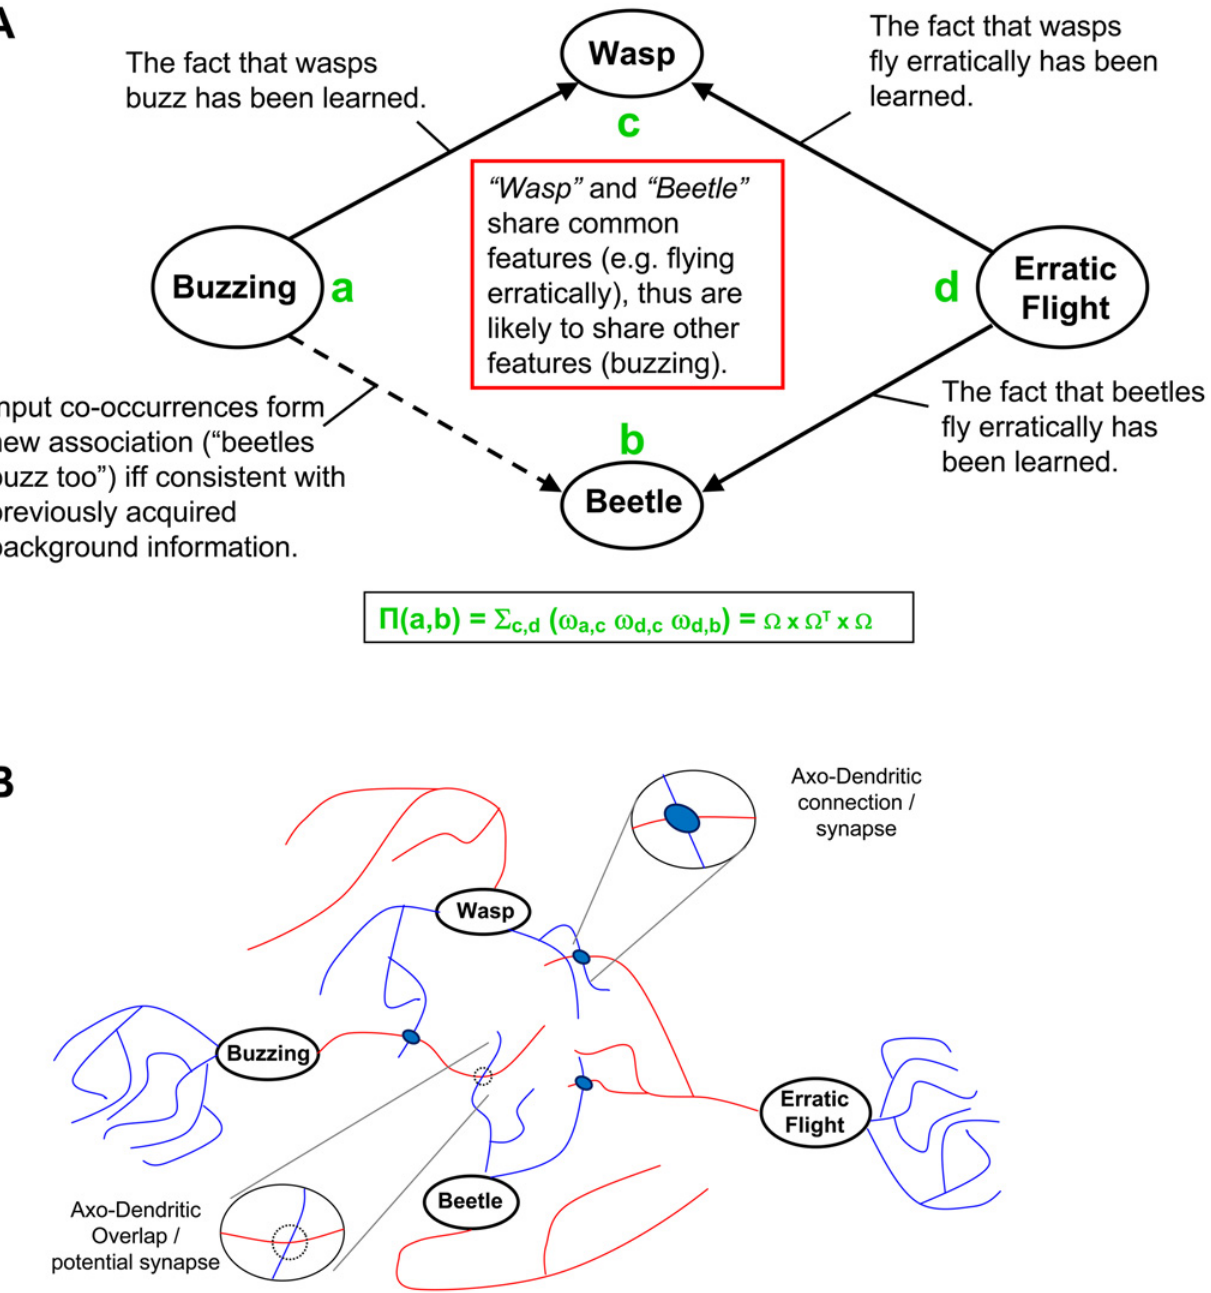
Fig 1. Instantiation of background information-gated (BIG) learning by the neuroanatomical mechanism of axonal-dendrite overlap (ADO). A . Cognitive model: Previously acquired background information, reflected in the structure of the association network, provides a gating mechanism for the formation of novel associations. The ability to acquire the new piece of information (associating the buzz to the beetle) depends on prior knowledge of relevant facts: in this example, that other buzzing animals (e.g. wasps) fly erratically. The green fonts a , b , c , and d refer to the proximity formula (also in green), fully described in the Materials and Methods. B . Neural correlate: In this simplified ( “ grandmother ” cells) model, each concept of panel A is represented by a single neuron, with axonal and dendritic trees drawn respectively in red and blue. The axon of the “ Buzzing ” neuron has a synaptic contact with the dendrite of the “ Wasp ” neuron. Thus, it must pass close to the dendrites of other nearby neurons. Neurons are likely to be near each other if they receive synapses from the same axons. Here, “ Beetle ” is near “ Wasp ” as they both receive synapses from the axon of the “ Erratic Flight ” neuron. Thus, prior knowledge of relevant background information, instantiated by the three existing synapses, provides proper conditions to learn the new association, i.e. forming the “ Buzzing ” - “ Beetle ” synapse.